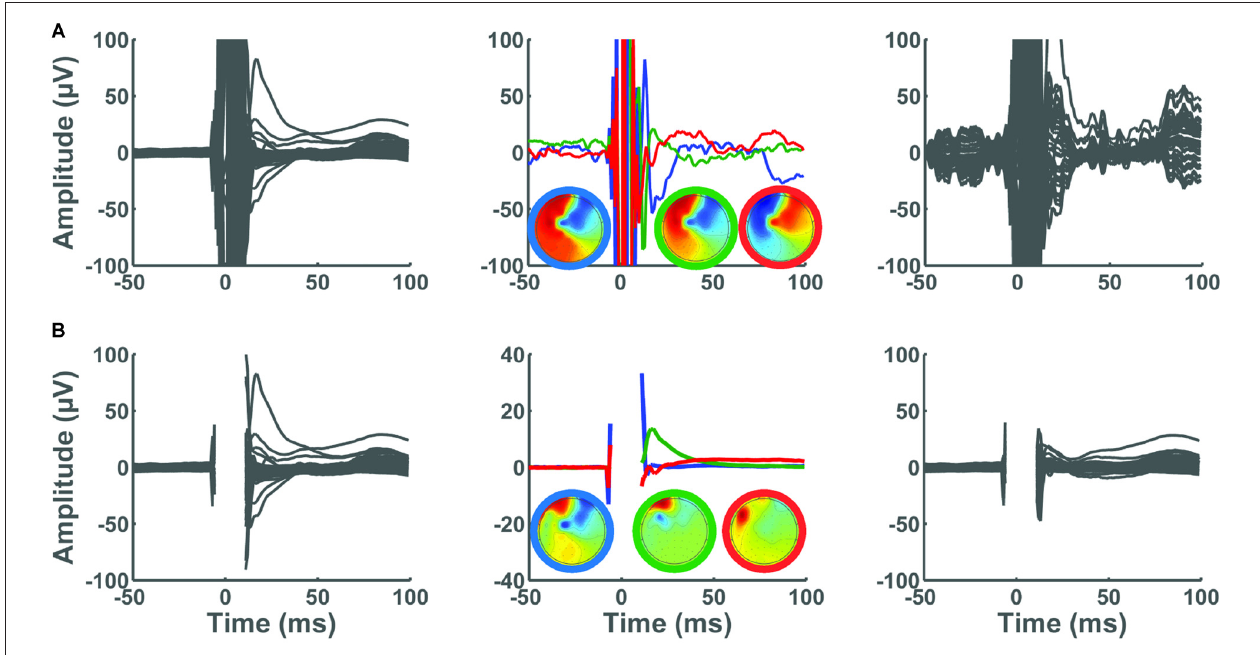
FIGURE 11 | Consequence of removing the large-amplitude TMS pulse artifact on the performance of ICA. In all panels, x-axes represent time in milliseconds relative to presentation of TMS pulse and y-axes represent the amplitude of the EEG signal in µ V. The left panels show the average butterfly plot of the TEPs, depicting mean TEP (averaged across trials) for each channel before removing ICA components. The center panels depict the three largest ICA components identified in Step 4. In these panels, the three topographical maps are color coded to match their corresponding ICA components in the time domain. The right panels illustrate the average TEP after removing the three ICA components. (A) TMS pulse artifact was not deleted in Step 2. The ICA was not able to remove the decay artifact. (B) TMS pulse artifact was cut by removing a data segment between − 5 ms to 10 ms. The TMS decay components were successfully removed using